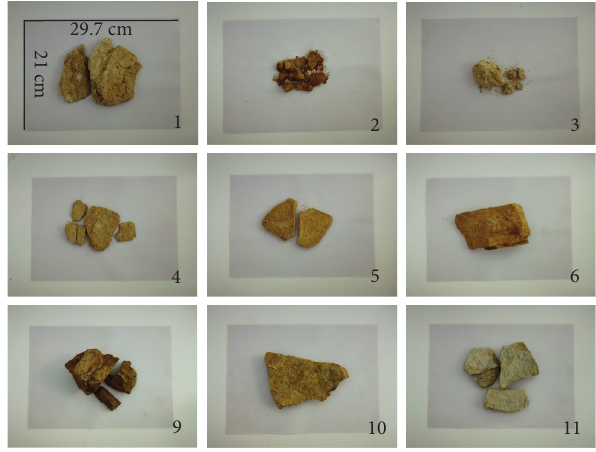
Figure 8: Rock samples of the secondary weak structures.